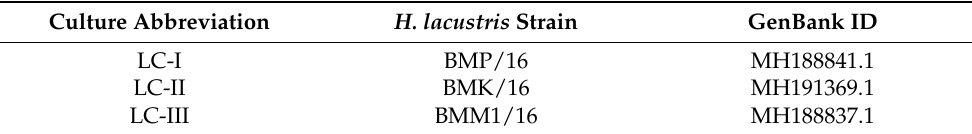
Table 1. Description of laboratory Haematococcus lacustris cultures taken as a control for the analysis. Culture